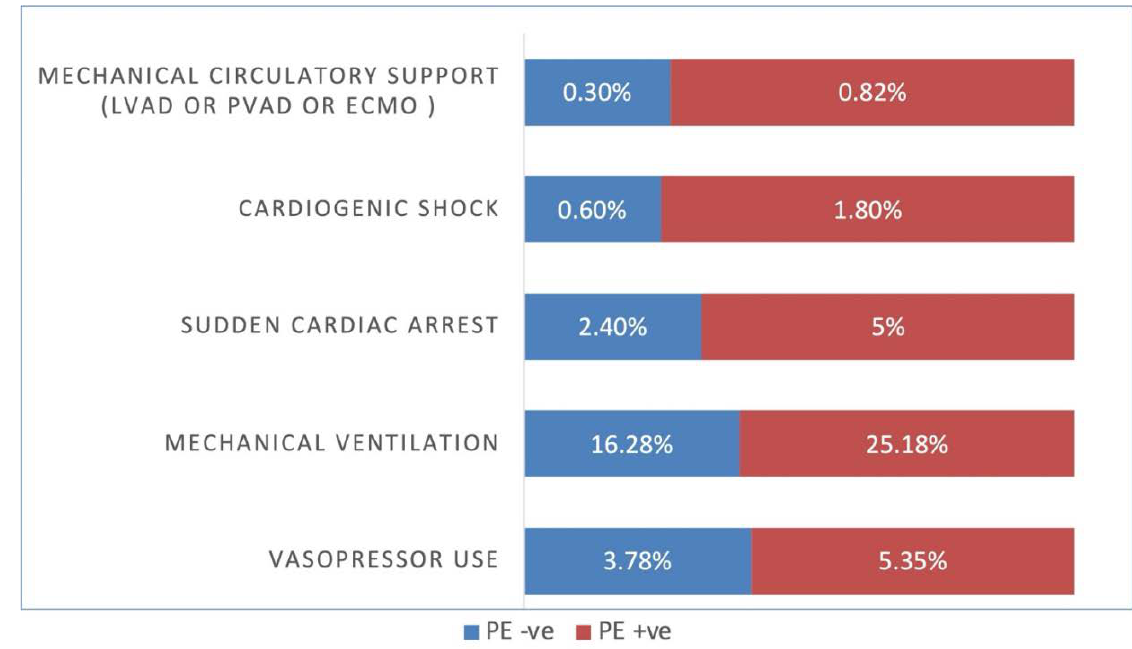
Figure 3. COVID-19 and Pulmonary embolism (PE) patient complications. LVAD = left ventricular assist device, PVAD = percutaneous ventricular assist device, ECMO = Extracorporeal membrane oxygenation, +ve = Positive, − ve = Negative.